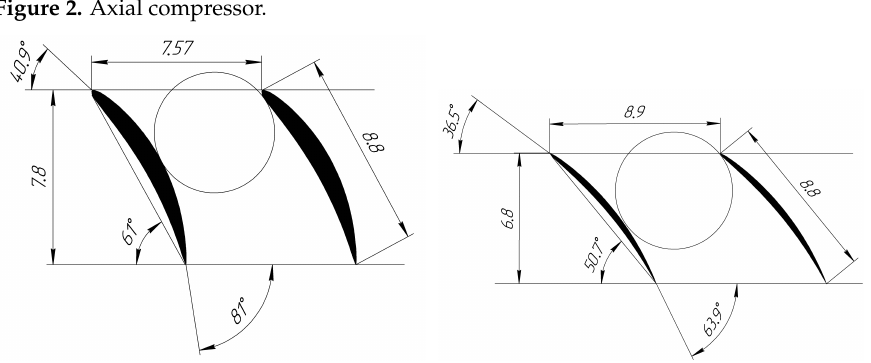
Figure 2. Axial compressor.